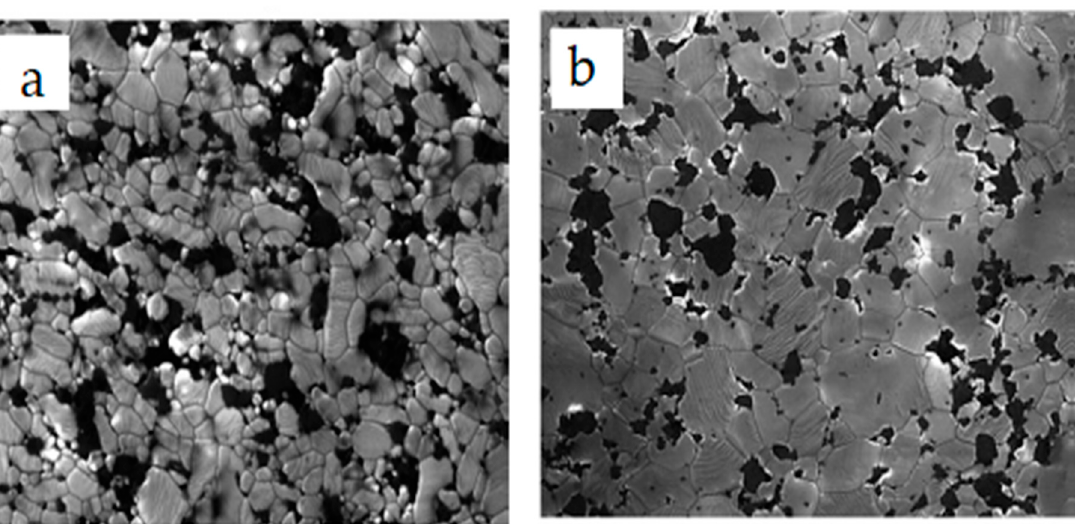
Figure 4. Field-emission scanning electron microscopy (FE–SEM) microstructure of Al 2 O 3 –SiC nanocomposites: ( a ) 1400 °C; ( b ) 1500 °C at 2 µm magnifications. Reproduced with permission from [86]. Copyright Elsevier, 2012. [86].